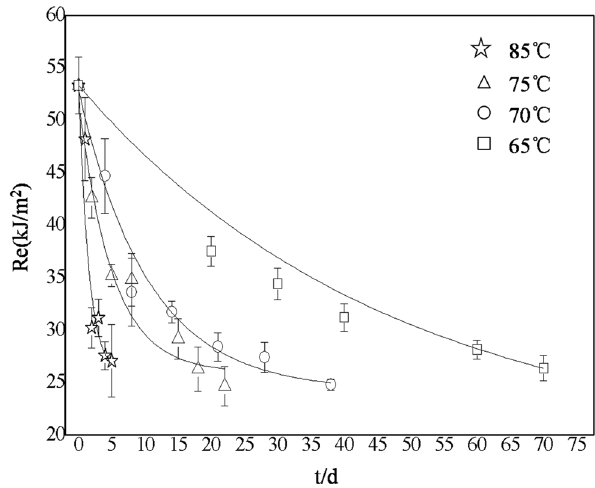
Figure 6: Changes in impact resistance of GaTo with error bars at 85, 75, 70, and 65°C.